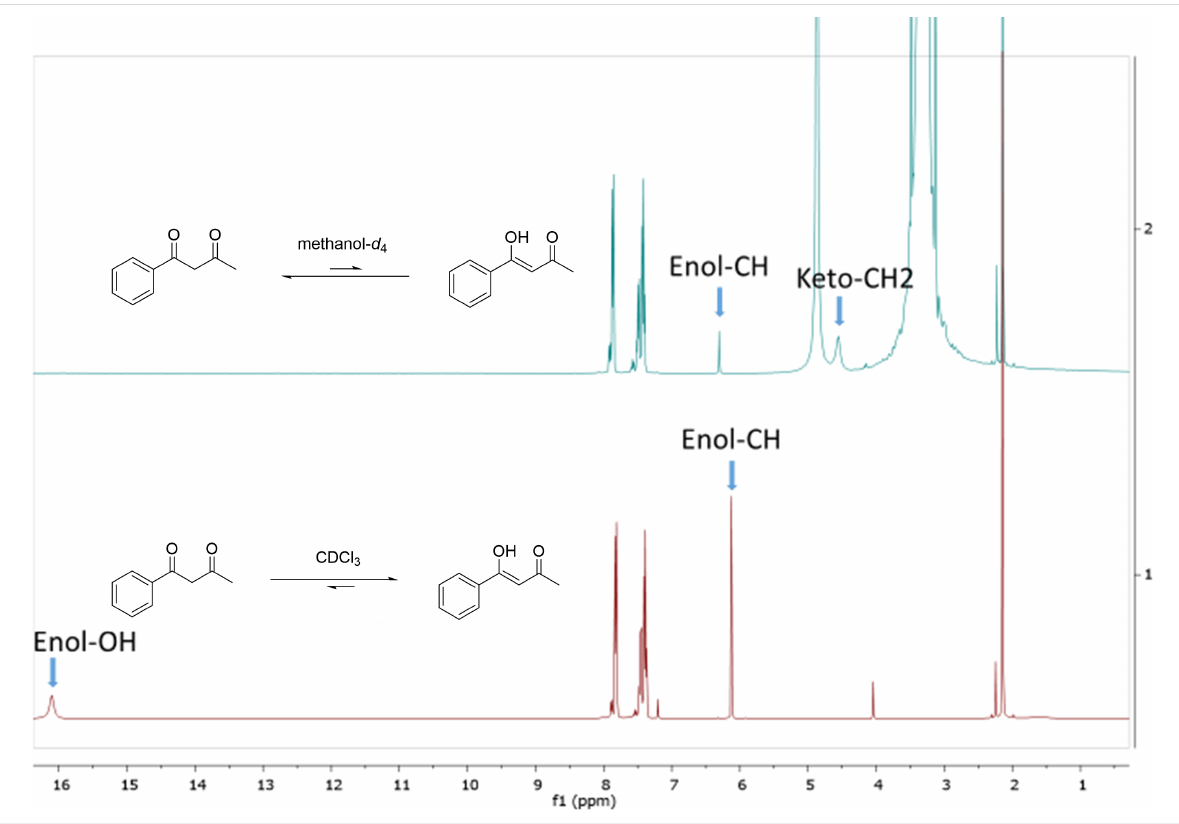
Figure 7: 1 H NMR spectra of 1-phenyl-1,3-butanedione ( 2a ) in methanol- d 4 (top) and in CDCl 3 (bottom).